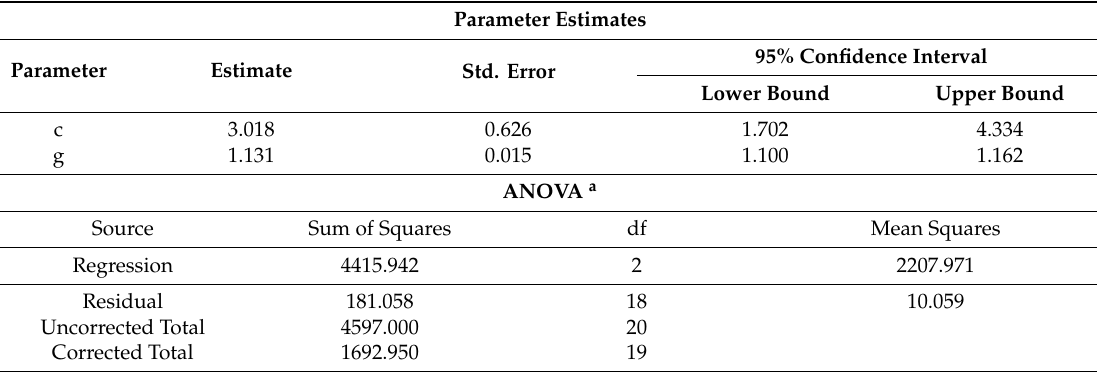
Table 1. Values of the parameters obtained with the exponential model.